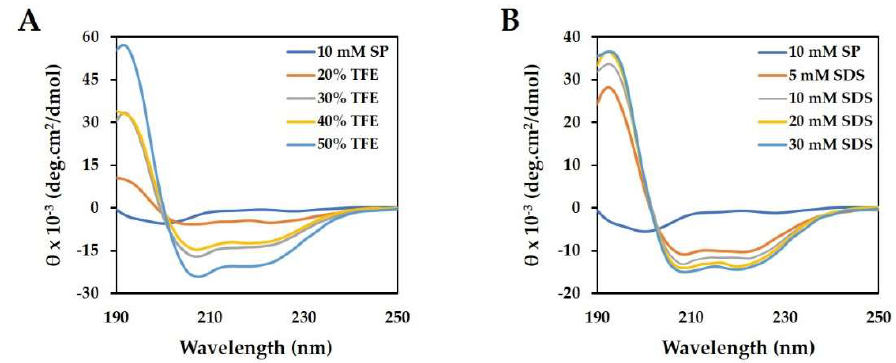
Figure 2. Circular dichroism (CD) spectra of magainin 2. ( A ) The peptide was measured in TFE, which mimics the hydrophobic environment of the microbial membrane and ( B ) SDS, which mimics the negatively charged prokaryotic membrane environment. Table 2. Mean residual ellipticity at 222 nm ([ θ ] 222 ) and percent α -helical contents of magainin 2 in various